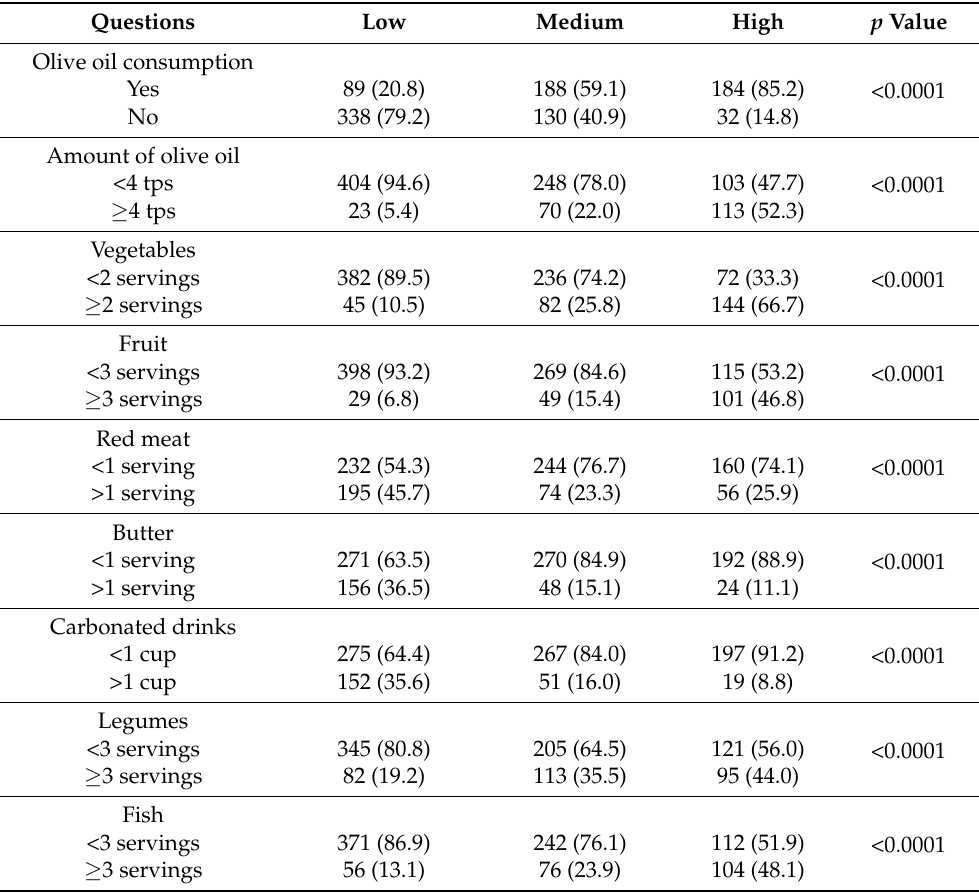
Table 3. Frequencies of 14-item questionnaire response according to level of adherence to the Mediterranean diet (MedDiet) in total sample